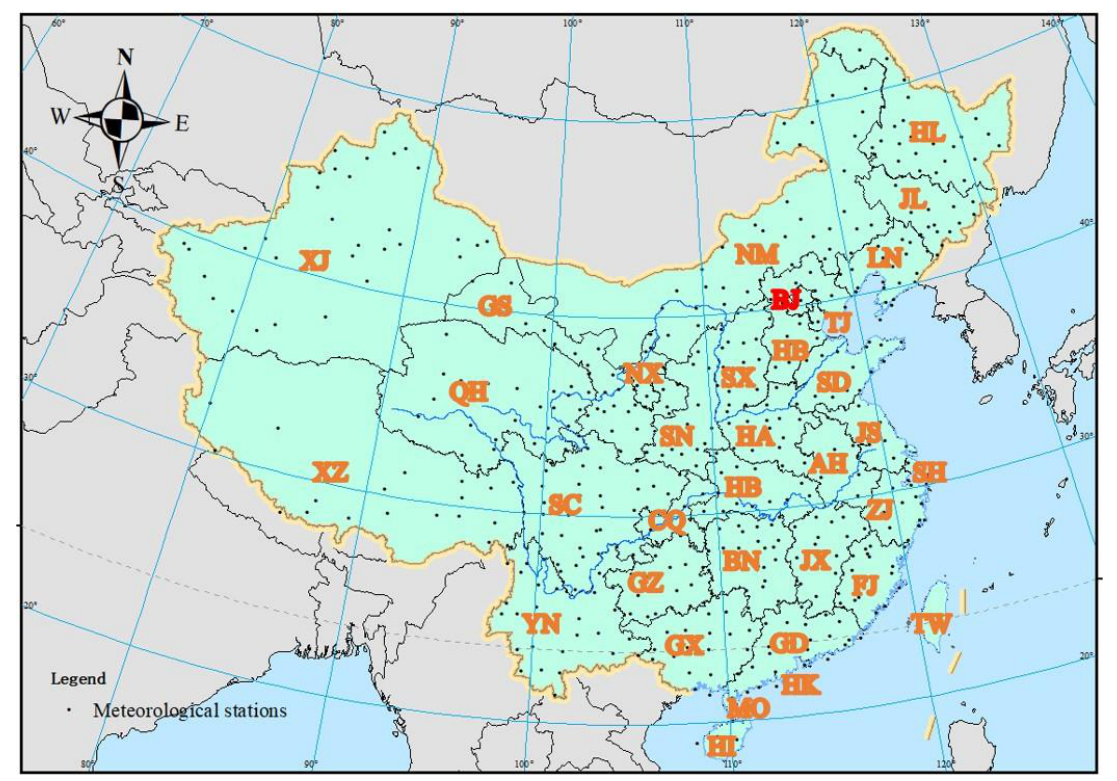
Figure 1. The study area and locations of the meteorological stations (the dots). Table 1. The study area, province, and corresponding number of stations.